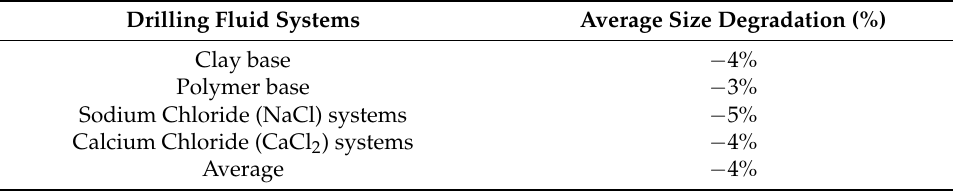
Table 5. Walnut size degradation (30 min shearing only).